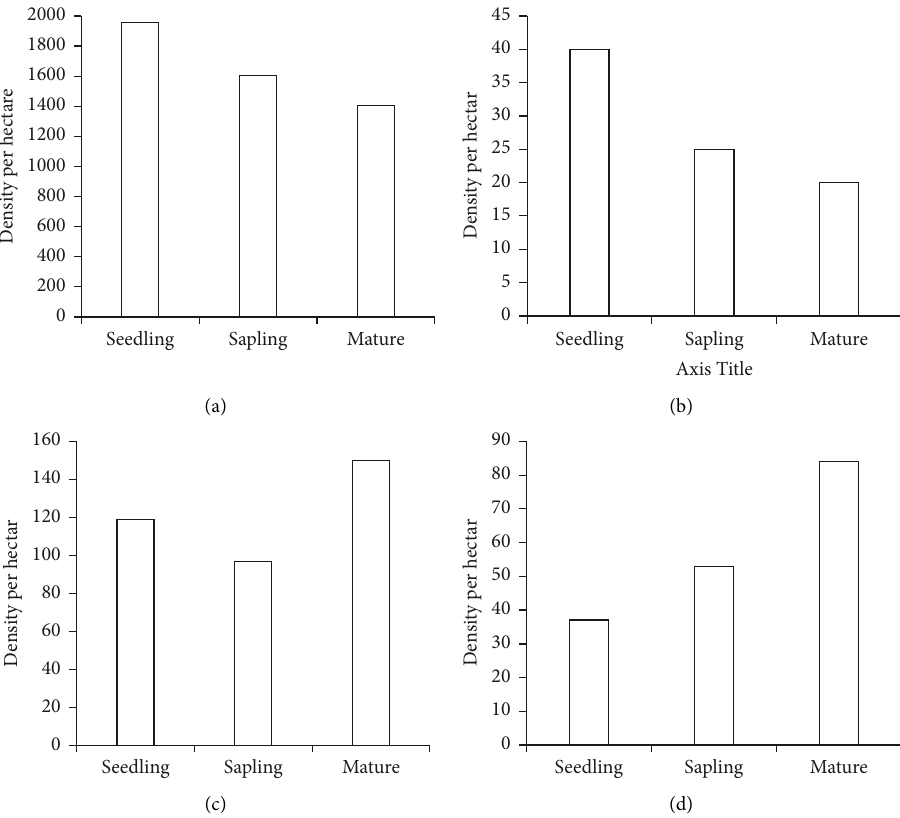
Figure 3: Representative population structure patterns of woody plant species in Tulu Korma afromontane forest based on densities of seedlings, saplings, and mature individuals. Note: (a) is for all species combined and suggests good regeneration, (b) is representative species with good regeneration, (c) is representative species with fair regeneration, and (d) is representative species tending to have poor